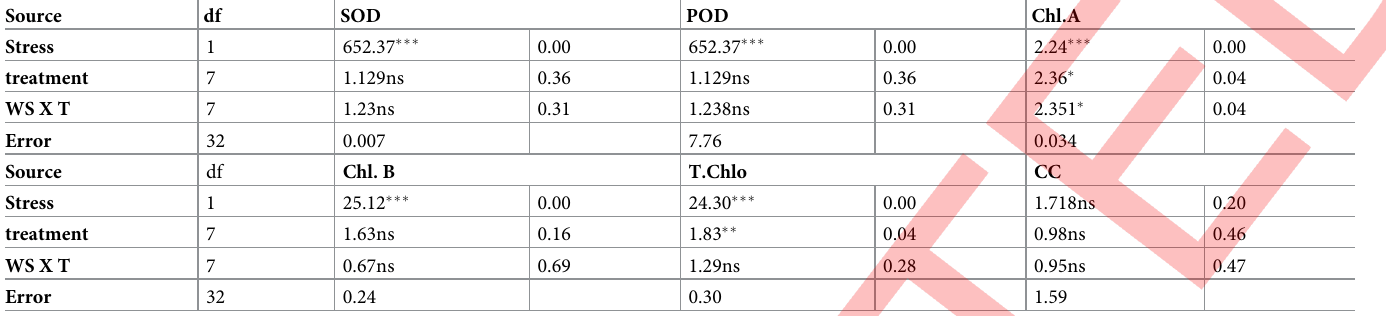
Table 1. Mean squares and p values from ANOVA of the data for Antioxidants and photosynthetic attributes and the nutrients in shoots of water stressed maize plants treated with foliar sprinkle of ZnSO 4 and Zn-Asp and L-Asp (df @0.005).